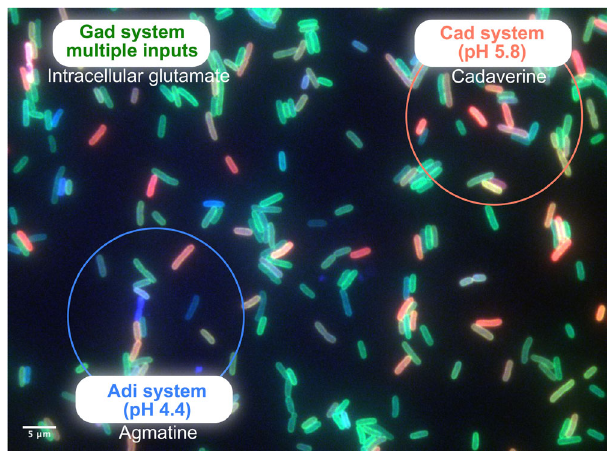
Fig. 7 Model of the heterogenous activation of three inducible acid resistance systems and division of labor in the E. coli population. Fluorescent microscopic images of the three-color reporter strain E. coli gadC:eGFP - adiC:mCerulean-cadB:mCherry at pH 4.4 in a complex medium at t 300 . All cells of the E. coli population individually adapt to acid stress by activating the Gad system to varying degrees (green fl uorescent cells) due to multiple extracellular and intracellular inputs. These cells utilize primarily intracellularly available glutamate under consumption of protons to increase their internal pH. Under stronger acid stress (pH 5.8 to pH 4.4), some cells in the population activate the Cad system (red fl uorescent cells), while others activate the Adi system (blue fl uorescent cells). These cells secrete (as indicated by the rings) the more alkaline products cadaverine and agmatine, respectively, thereby contributing to acid-stress relief with an increase of the extracellular pH, which bene fi ts the whole population. In addition, their internal pH is elevated by consuming protons due to the conversion of lysine to cadaverine and arginine to agmatine,